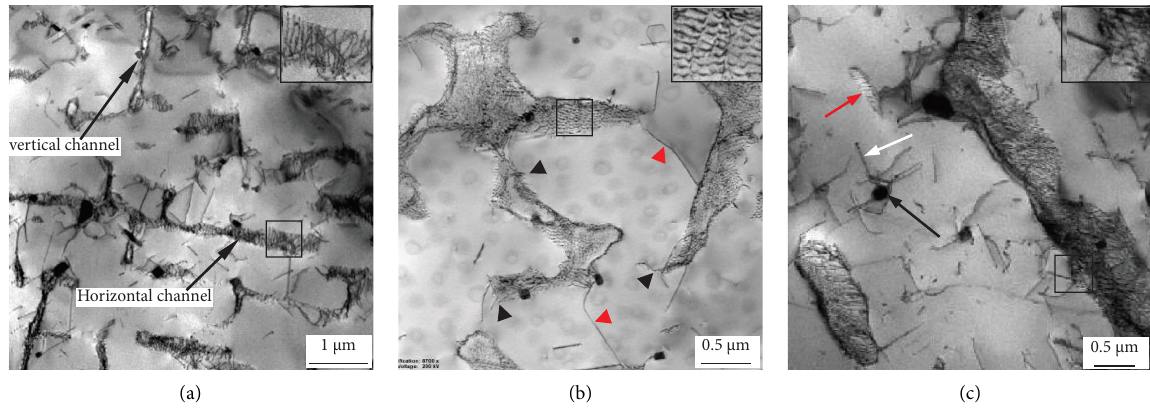
Figure 3: TEM images of the alloy creep diferent times at 1040 ° C/137MPa: (a) 6h, (b) 50h, and (c) 352